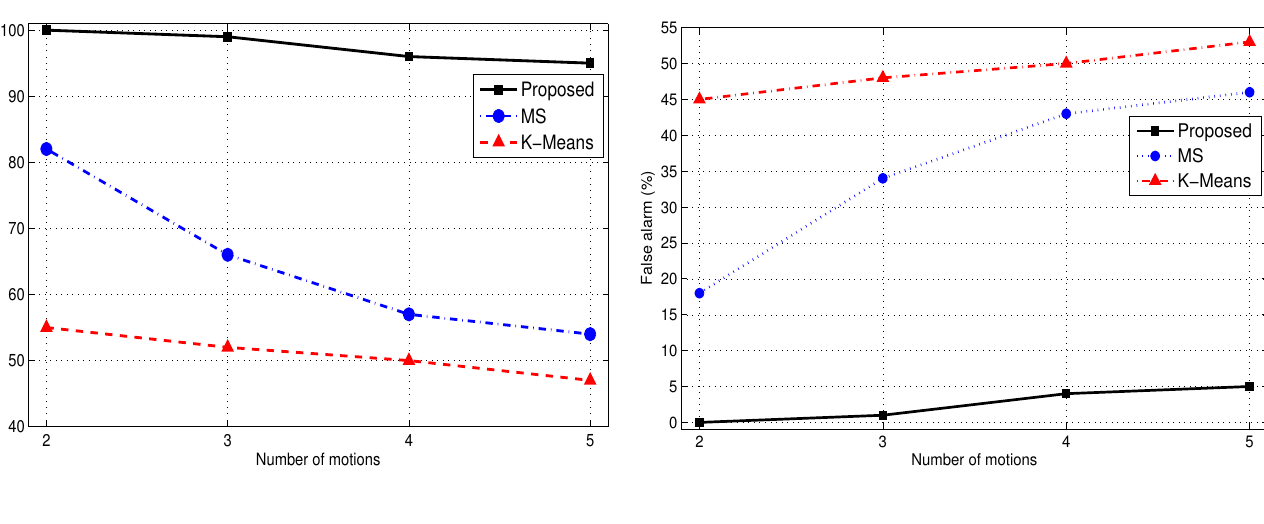
Figure 9. Hit rate ( left ) and false alarm ( right ) results for the proposed algorithm, the K-Means method, and the mean-shift method with varying number of motions.